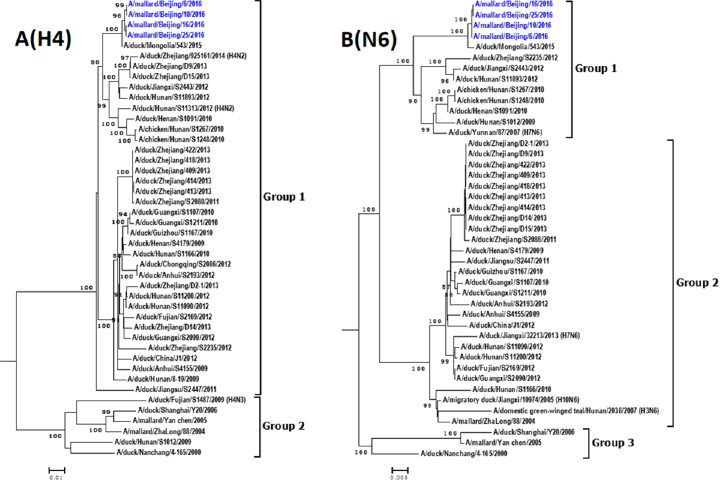
Fig 1. Phylogenetic trees of H4 (A) and N6 (B) genes of H4N6AIVs in China. Phylogenetic trees were generatedby the neighbor-joiningmethod and bootstrappedwith 1000 replicates using MEGA6. Analysis was basedon nucleotides1–1693of the HA gene and 1–1413of the NA gene. Virus subtypes that are not H4N6 are indicatedin brackets. Virus strains isolated in this study are highlighted in red.